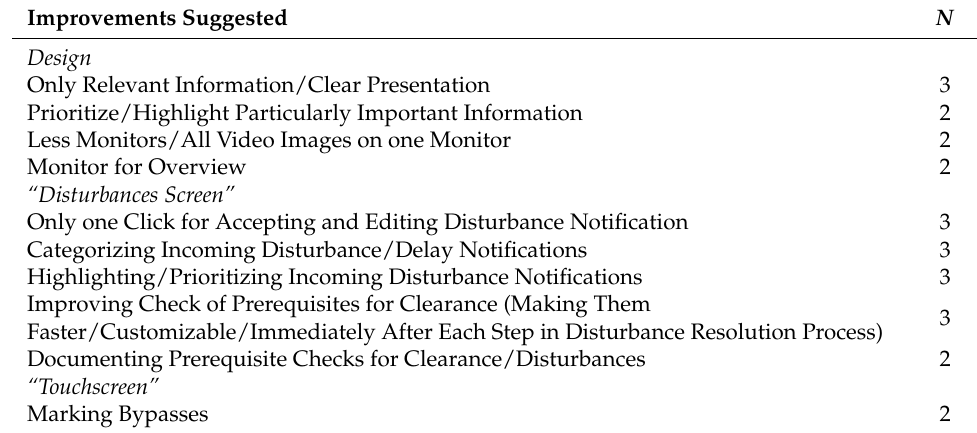
Table 11. Overview of additional suggestions for